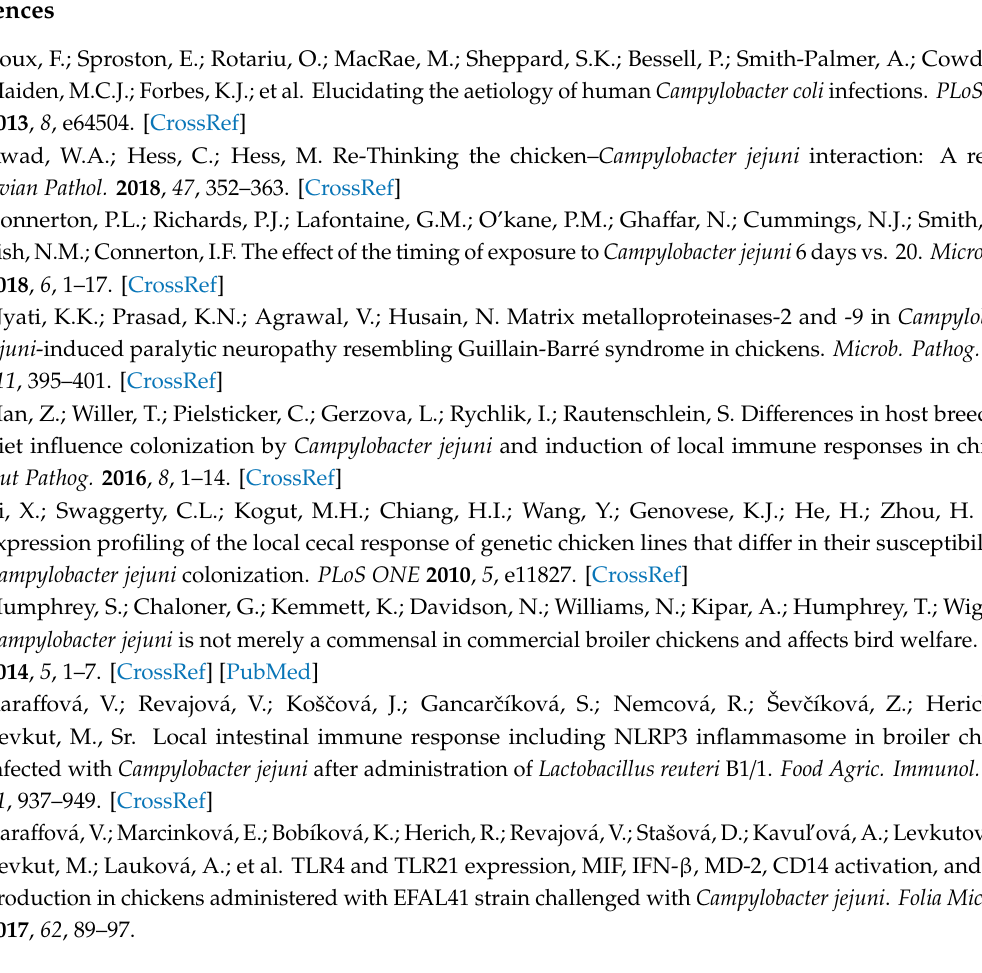
Table S1: Relative mRNA expression of caecal pro-inflammatory cytokines in probiotic and pathogen-colonized chickens, Table S2: Raw